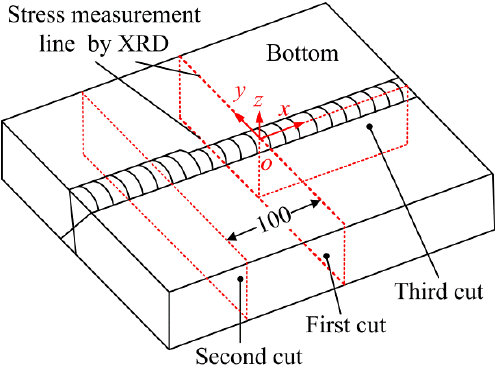
Figure 3. Schematic diagram of the cut planes.